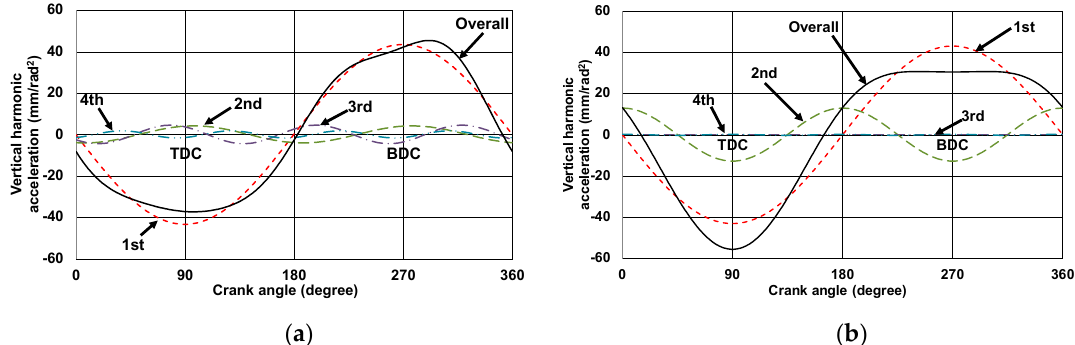
Figure 11. Vertical harmonic acceleration components at piston pin in single cylinder engine: ( a ) final design of the Stephenson III mechanism and ( b ) the slider-crank mechanism.